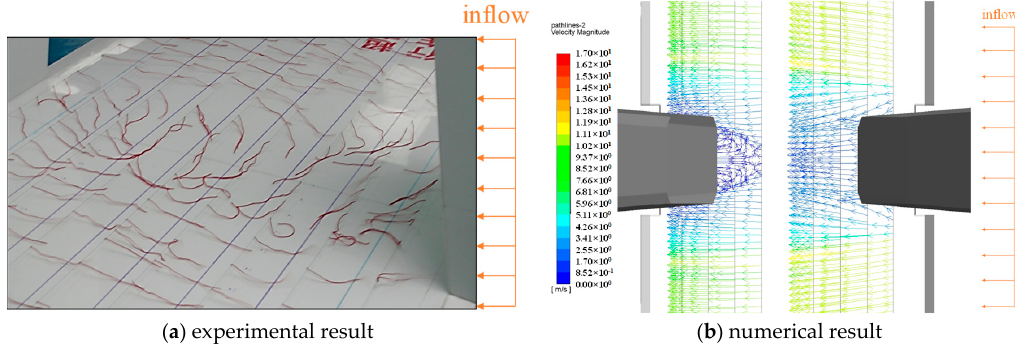
Figure 11. Vortex zone (at 0.25 H above the deck, C2 condition).